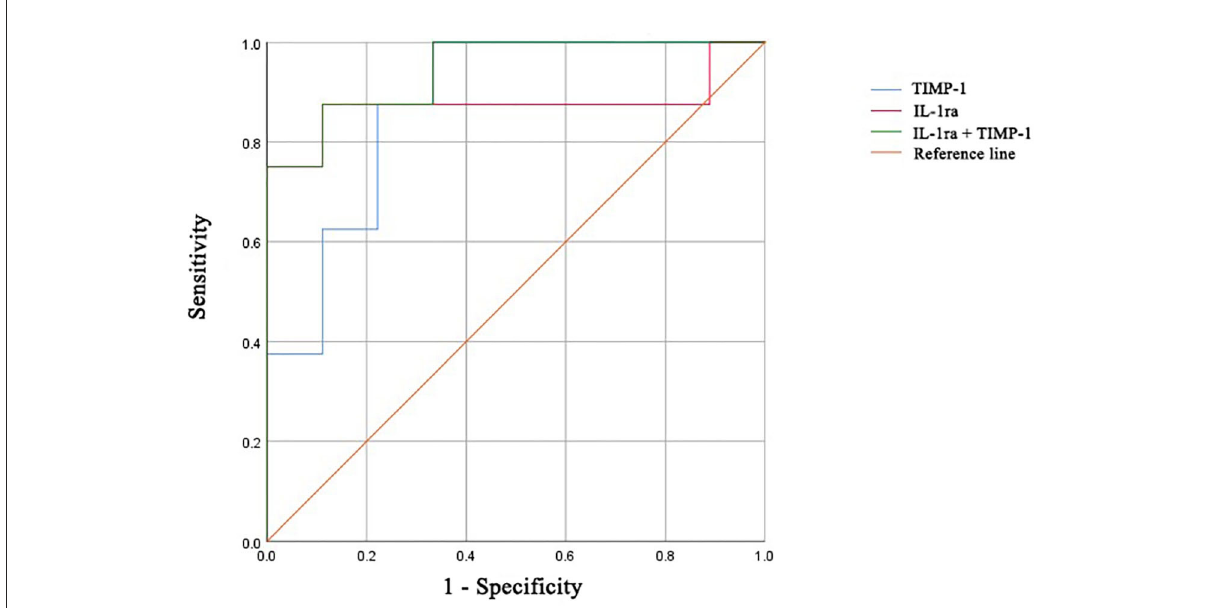
FIGURE5 ROC curves of IL-1ra, TIMP-1, and the combination for distinguishing patients with DM from patients with ASS. ROC, receiver operating characteristic; IL-1ra, IL-1 receptor type 1; TIMP-1, tissue inhibitor of metalloproteinases-1; DM, dermatomyositis; ASS, anti-synthetase